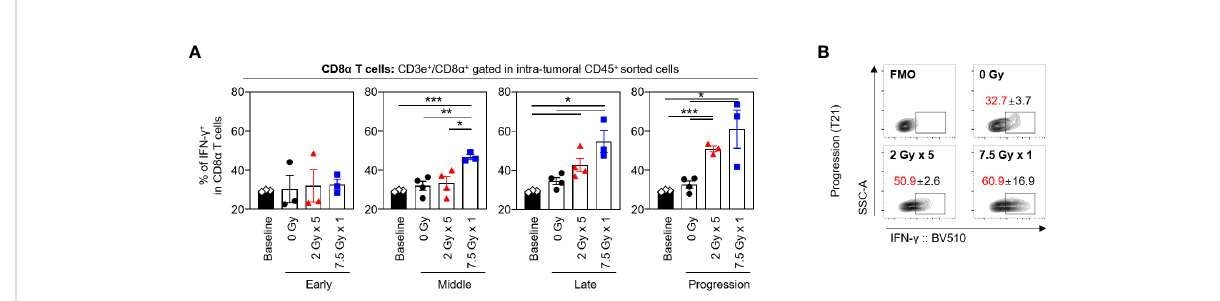
FIGURE 6 Sequential changes in the population of the intratumoral effector CD8 a T cells after RT. (A) Altered proportions of IFN- g + CD8 a T cells at each time phase. (B) Representative contour plot images of the IFN- g + population at the progression phase. All data are presented as mean ± SEM. * P < 0.05, ** P < 0.01, and *** P < 0.001 based on unpaired two-tailed t -test. Results of one-way ANOVA analyses for each time phase are listed in Table S4. These fi gures are based on the representative data obtained from at least two independent experiments. The contour plots of (B) are from representative individual samples. Abbreviations: RT, radiotherapy; IFN, interferon; SEM, standard error of the mean; ANOVA, analysis of